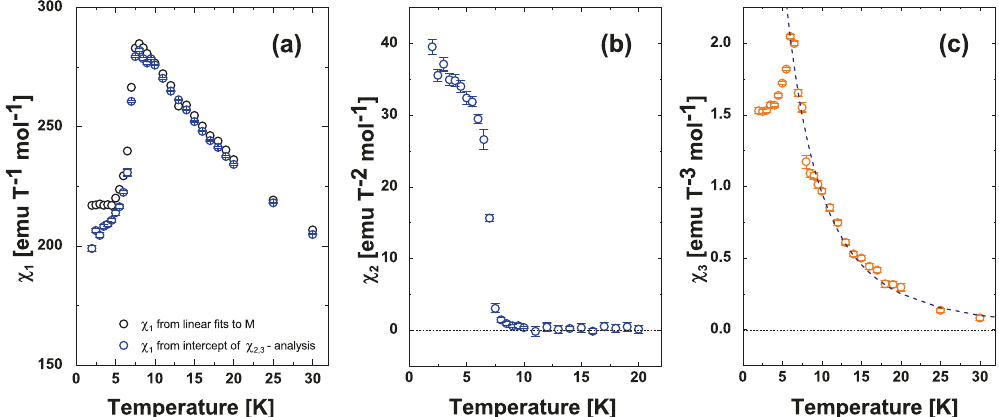
Fig. 3 Linear and higher-order susceptibilities. Panel ( a ) shows the linear susceptibility obtained through temperature sweep (black circles) as well as those obtained from the intercepts of the magnetization isotherms of the χ 2 and χ 3 analysis such as in Fig. 2 (blue circles). Panel ( b ) shows χ 2 extracted from the low fi eld quadratic response, from plots such as in Fig. 2, top nine panels. Similarly, panel ( c ) shows the temperature dependence of χ 3 obtained from plots such as those in Fig. 2, bottom nine panels. A sharp “ lambda ” -like anomaly is apparent for fi eld (3 – 5 T) response when B ∥ a -axis. The error bars capture the coef fi cient of determination of the linear fi ts such χ 3 obtained from the high as shown in Fig.